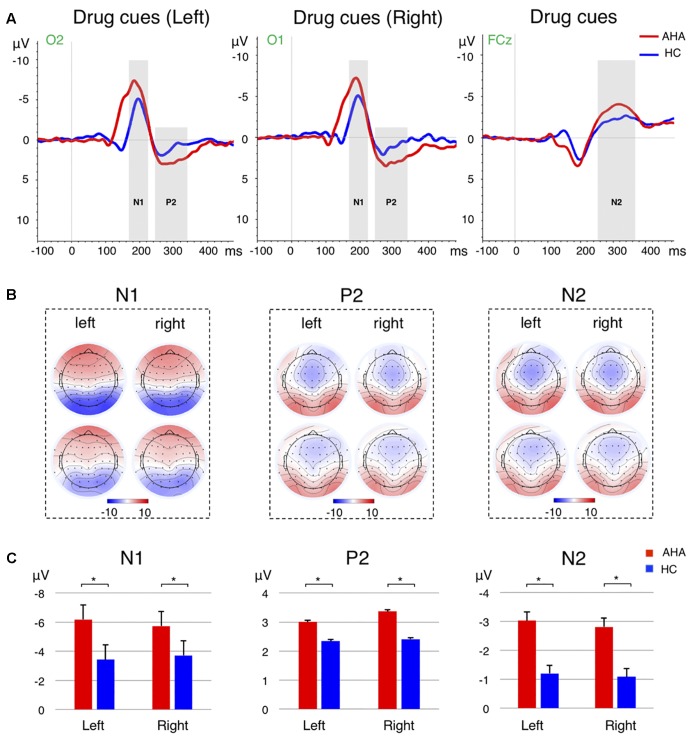
Event-related potential (ERP) analysis for the image-related responses. (A) The grand average ERP waveforms for the image-related responses from the selected electrode for the drug cues in the left (Left), drug cues in the right (Middle), and the averaged across left and right cases (Right). The N1 and P2 ERPs for the drug cues presented in the left are from the O2 electrode, whereas the ERPs for the drug clues in the right are from the O1 electrode. The N2 waveforms are extracted from the FCz electrode. The time windows for N1, P2, and N2 are marked by the gray shadow, where were 170–220 ms, 240–320 ms, and 250–350 ms, respectively. The red and blue lines refer to AHA and HC group, respectively. (B) Scalp topography of the N1 (Left), P2 (Middle), and N2 (Right) components for left and right drug cues, for AHA and HC groups, respectively. The components are averaged across subjects and time windows. (C) Bar plots show mean and standard error of the intensity of N1 (Left), P2 (Middle), and N2 (Right) components for AHA group (red) and HC group (blue), respectively. Error bars denote standard error. ∗p < 0.05.